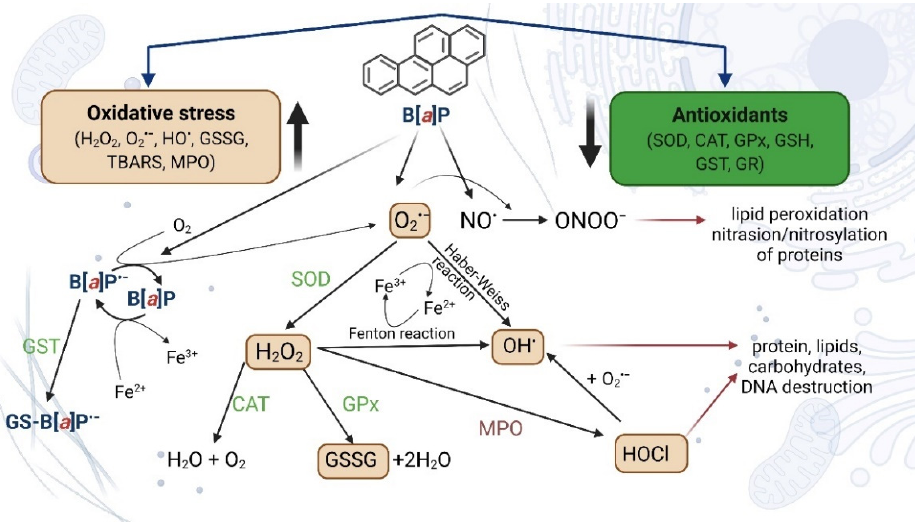
Figure 5. Environmental pollutants, such as B[ a ]P, affect the balance between the production of reactive intermediates and the biological system of ROS detoxification. The presence of B[ a ]P in the cell environment induces various molecular changes, such as lipid peroxidation or protein oxidation. B[ a ]P · − , anion B[ a ]P radical; O · − 2 , superoxide anion; H 2 O 2 , hydrogen peroxide; OH • , hydroxyl radical; HOCl, hypochlorous acid; NO, nitric oxide; ONOO-, peroxynitrite; GS-B[ a ]P, glutathione- B[ a ]P conjugate; GSSG, glutathione disulfide (oxidized glutathione dimers); GR, glutathione reduc- tase; GST, glutathione-S-transferase; CAT, catalase; SOD, superoxide dismutase; GSH, glutathione (reduced state); MPO, myeloperoxidase; TBARS, thiobarbituric acid reactive substances [107–110]. Created with BioRender.com (accessed on 12 April 2022).